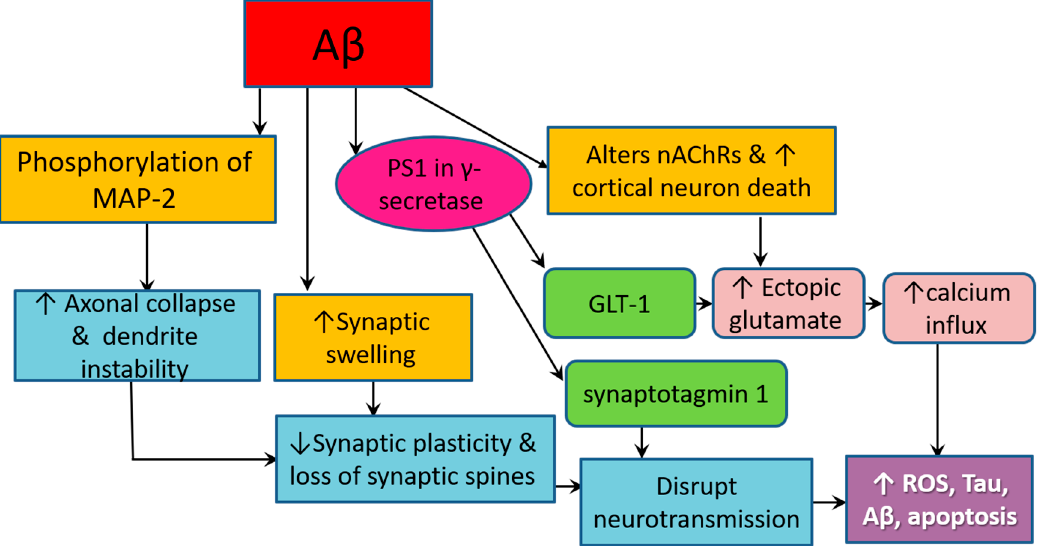
Figure 3. Schematic illustration of the mechanism underlying synaptic destruction by beta-amyloid peptide (A β ). Abbreviations : ↑ denotes increase, ↓ denotes decrease, A β : beta-amyloid protein fragments, MAP-2: microtubule-associated protein 2, PS1: presenilin 1, nAChRs: nicotinic